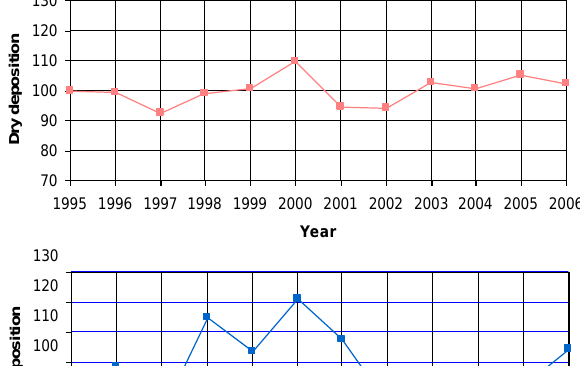
Fig. 12. Annual deposition to the Baltic Sea basin of oxidised dry, Fig. 12 . Annual deposition to the Baltic Sea basin of oxidised dry, oxidised wet, reduced dry oxidised wet, reduced dry and reduced wet nitrogen in the period and reduced wet nitrogen in the period 1995 – 2006, calculated with constant emissions from 1995–2006, calculated with constant emissions from 2006 and vari- 2006 and variable meteorology for all years. able meteorology for all years.